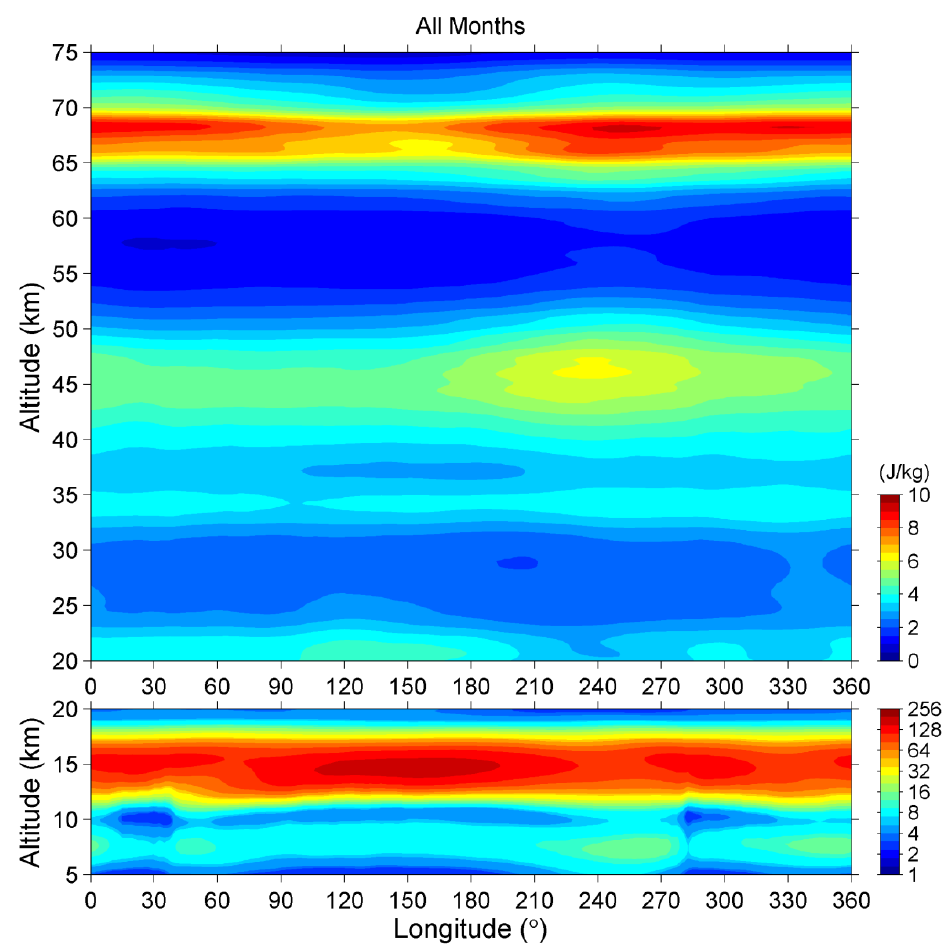
Figure 6. The longitudinal variation of the full-time-averaged E P . The figure uses the same design for color scaling as Figure 4.